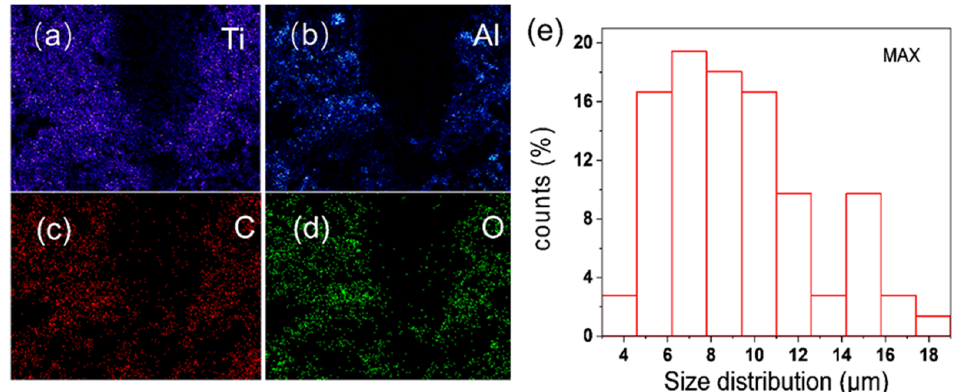
Figure 1. ( a – d ) SEM mapping map of titanium aluminum carbide (MAX). ( e ) The size distribution of MAX.